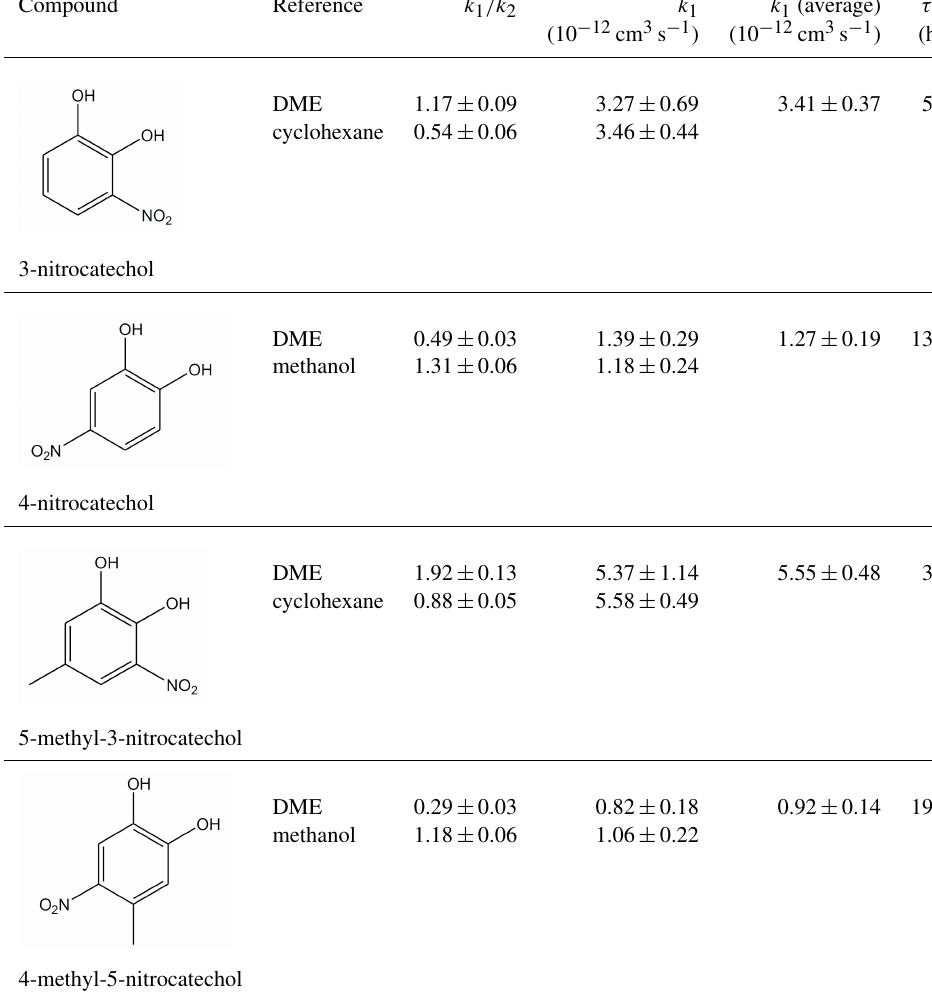
Table 1. Rate coefficient values of OH radical reactions with all investigated nitrocatechols in the present study.